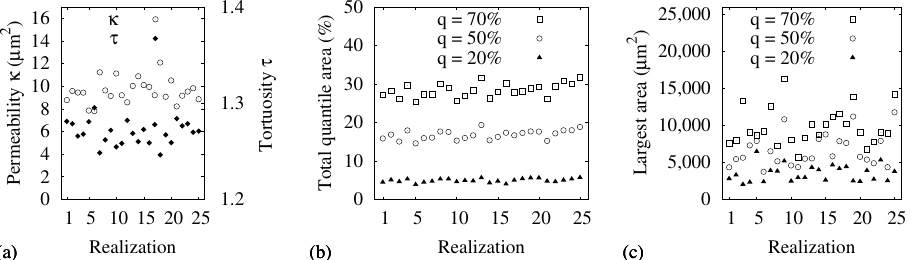
Figure 3. Characteristics of the uncompressed GDL. Slip condition at walls: ( a ) permeability and tortuosity; ( b ) relative total quantile areas of the gas flow; total area where u q ( z ) > 0. ( c ) The largest area from ( b